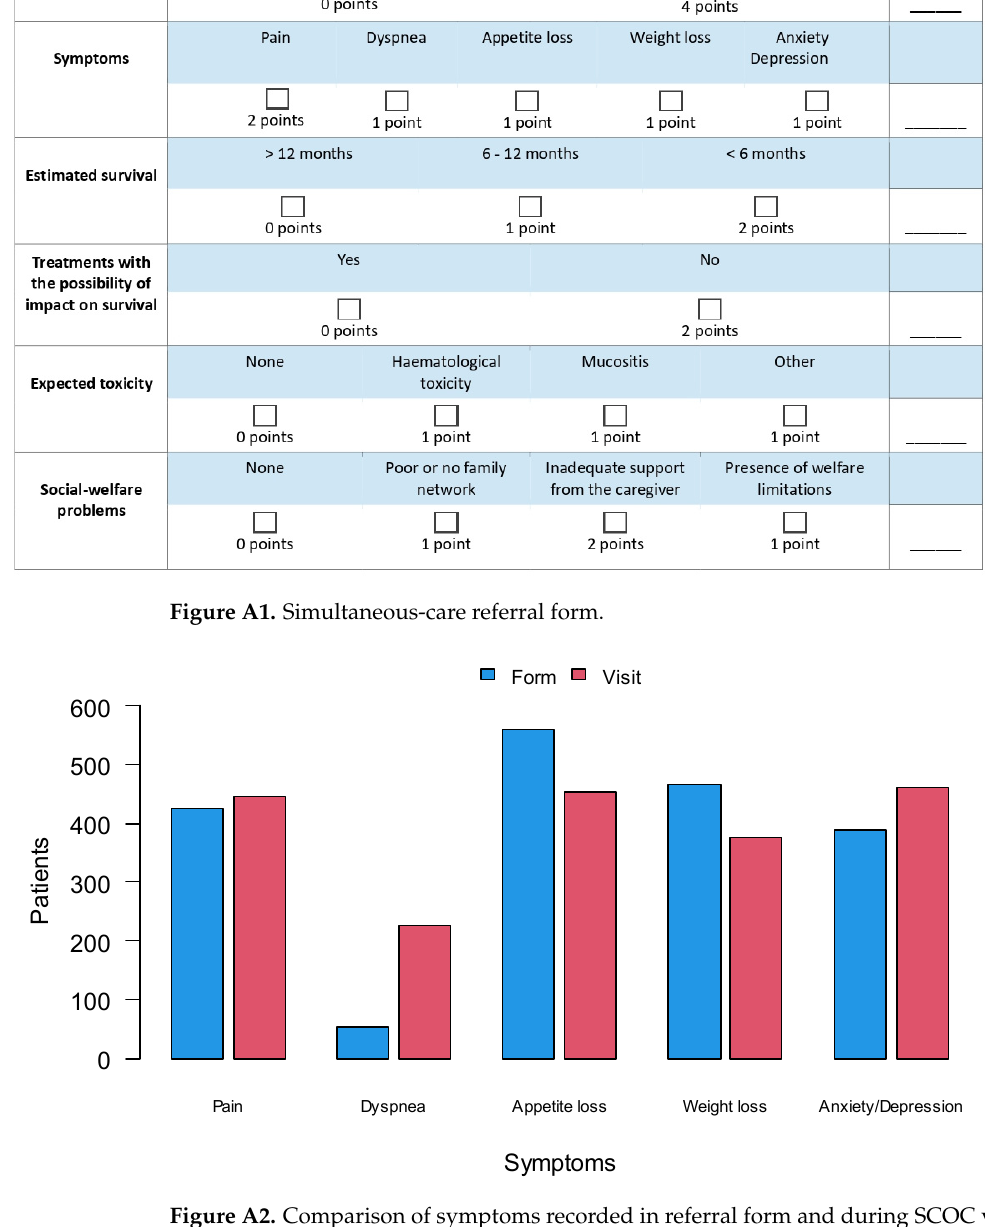
Figure A3. Symptom severity among patients, according to ESAS. Bars represent the absolute fre- quencies of symptoms grouped by three levels of severity. The number of patients for whom indi- vidual ESAS scores were available ranged from 661 to 675. References 1.